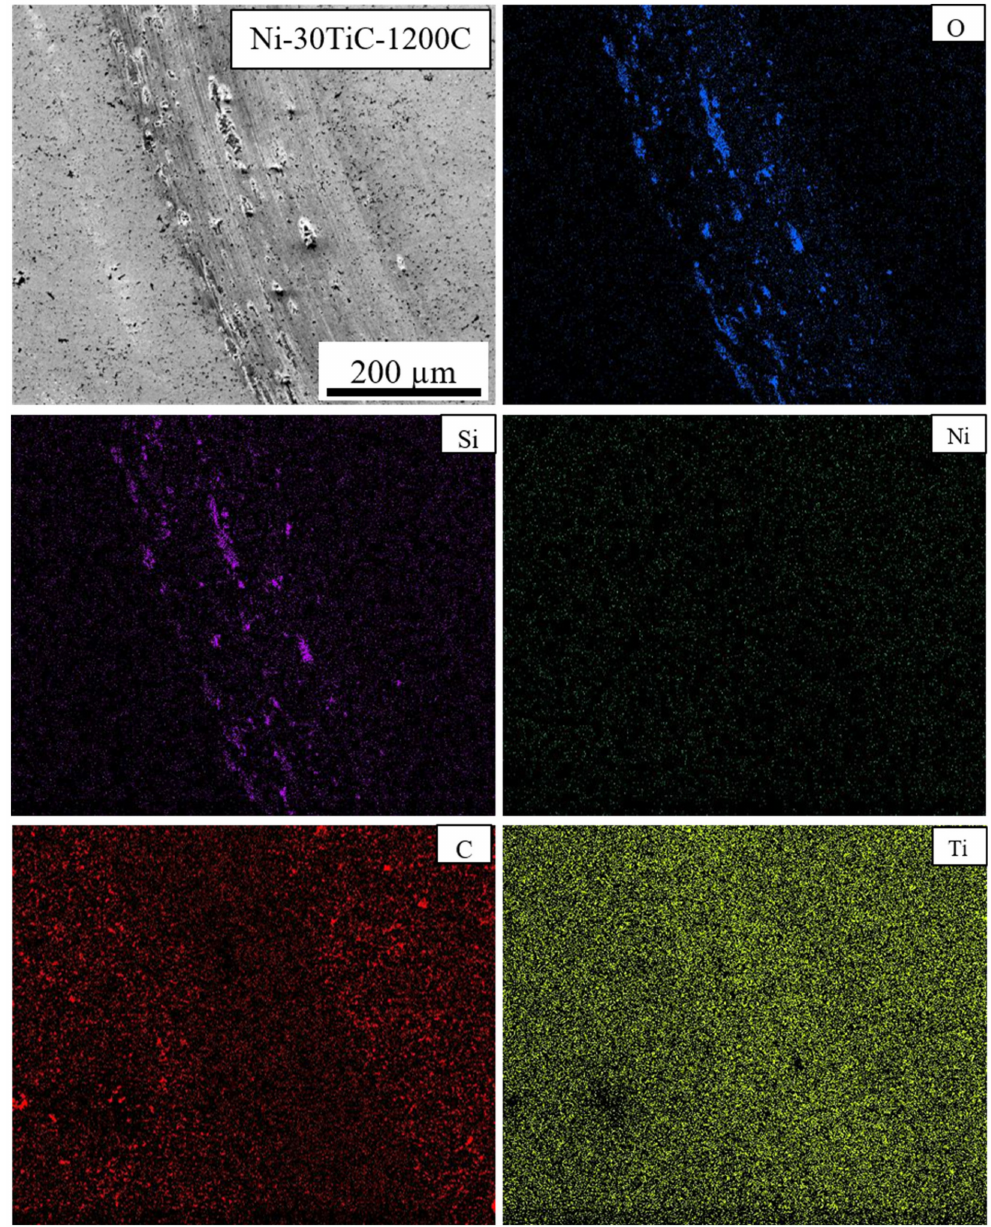
Figure 11. Wear Track EDS Map of